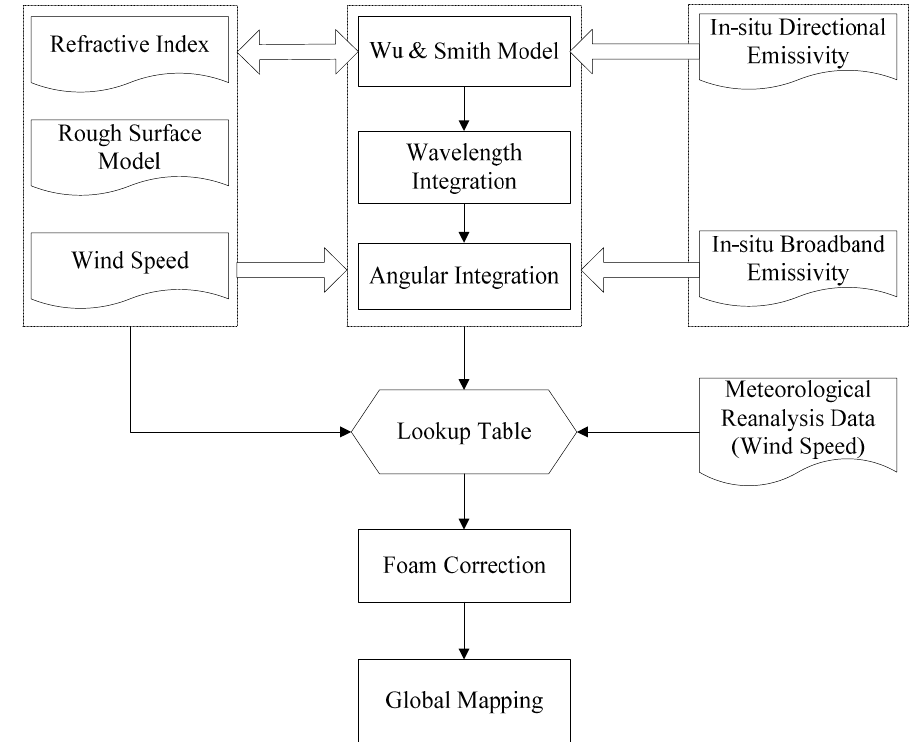
Figure 3. Flowchart describing the procedure for estimating global sea surface hemispherical broadband emissivity.